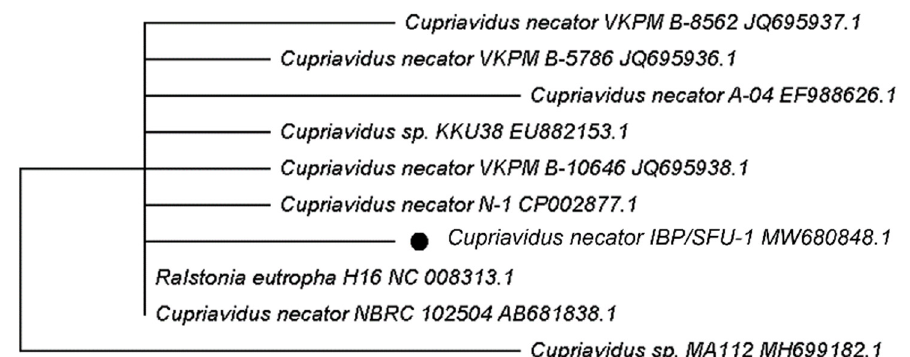
Figure 1. Neighbor-joining phylogenetic tree of Cupriadivus necator IBP/SFU-1 and related bacteria based on 16S rRNA sequence comparisons. Accession numbers are given. Bar, 0.0005 substitutions per nucleotide position.